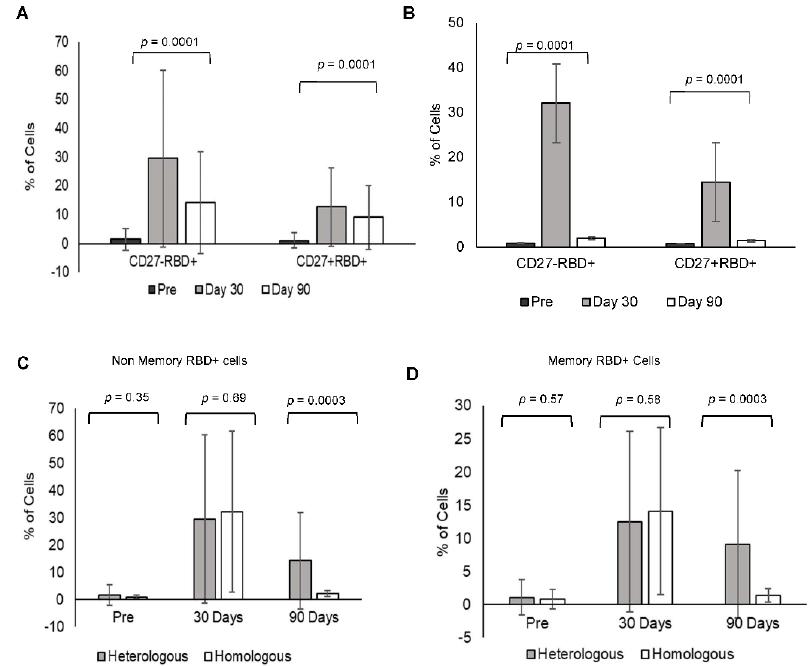
Figure 4. RBD-specific B memory and non-memory: individual analysis of RBD-specific non-memory and RBD-specific memory in heterologous and homologous booster groups at pre, day 30, and day 90 together and p values were shown between the groups ( A , B ). Comparison of RBD-specific B non-memory (RBD+CD27 − ) and memory (RBD+CD27+) B lymphocytes in individuals receiving heterologous ( C ) and homologous ( D ) booster vaccine at pre, day 30, and day 90 and p values were shown for the same. Homologous booster dose increased the RBD-specific B memory cells (CD27+) and B